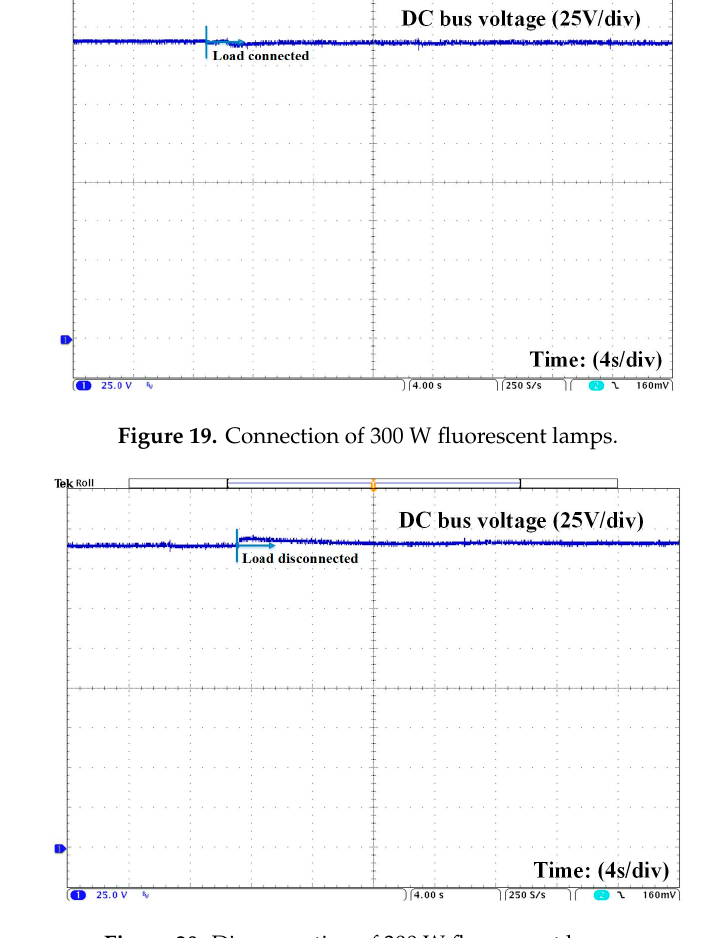
Figure 20. Disconnection of 300 W fluorescent lamps.